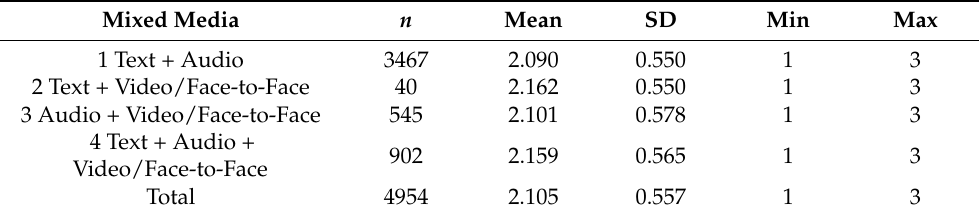
Table 5. Descriptive statistics—perceived social support in mixed media.